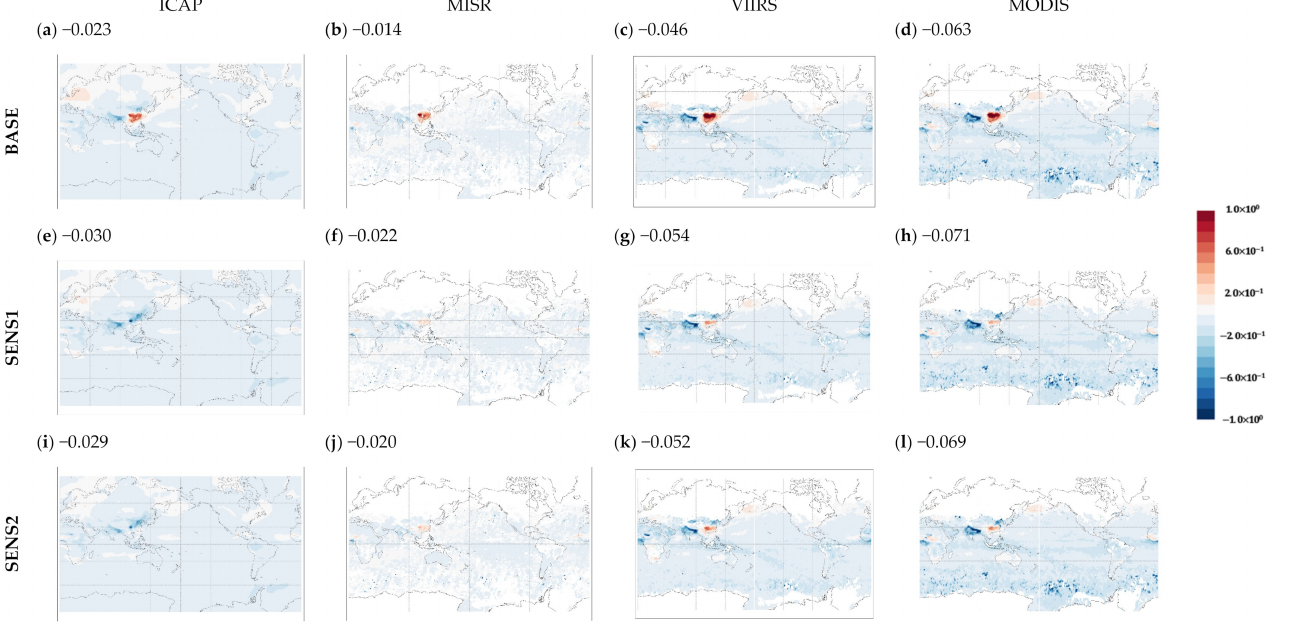
Figure 7. Global distribution of the differences in GEFS AOD ( BASE ( a – d ), SENS1 ( e – h ) and SENS2 ( i – l )) from ensemble simulation of ICAP ( a , e , i ), and satellite observations of MISR ( b , f , j ), VIIRS ( c , g , k ), and MODIS ( d , h,l ) in MAM 2021 (the numbers above figures indicate the global mean